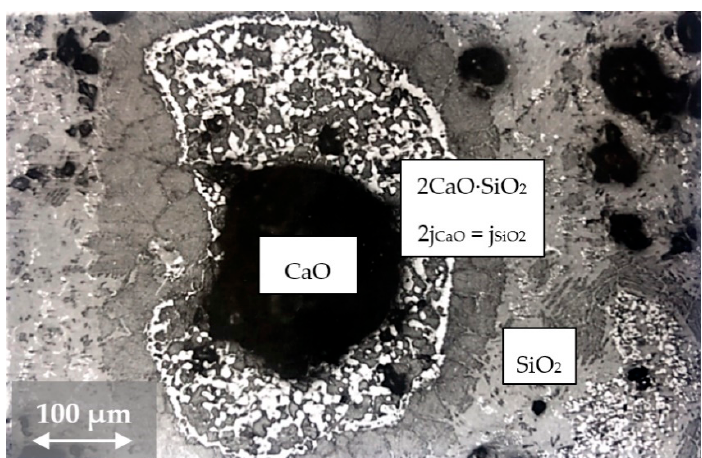
Figure 9. A small piece of undissolved lime in the slag from Melting Process C, sample C3, collected after minute 8 of oxygen blowing.